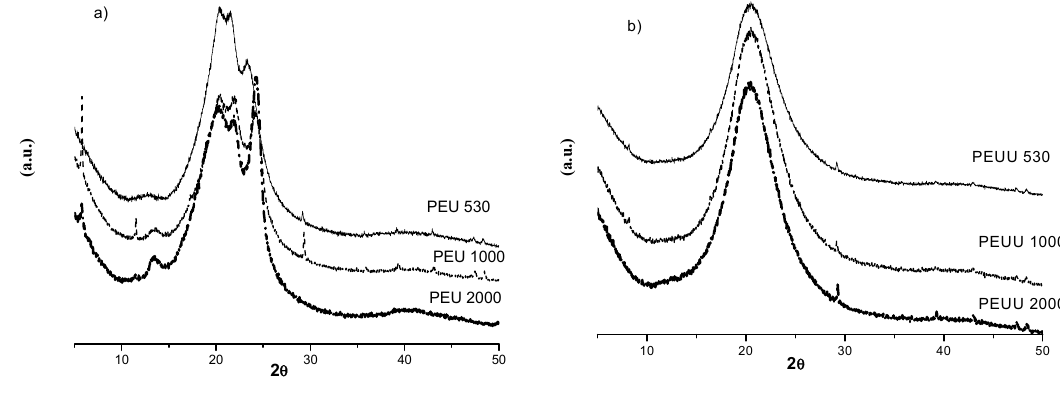
Figure 4. XRD patterns of ( a ) PEUs, and ( b ) PEUUs.